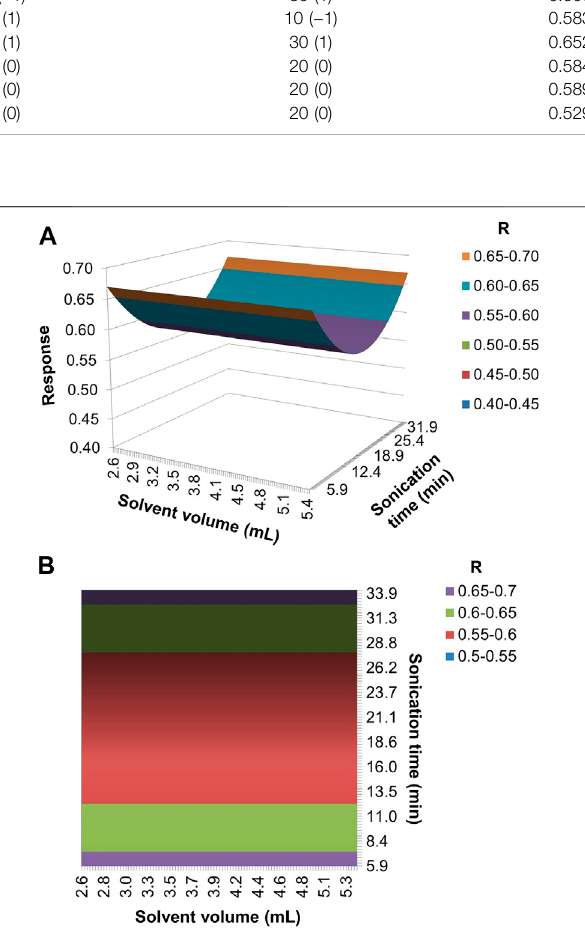
FIGURE 3 | (A) Response surface and (B) contour graph for the model generated by the re fi nement of the extraction conditions